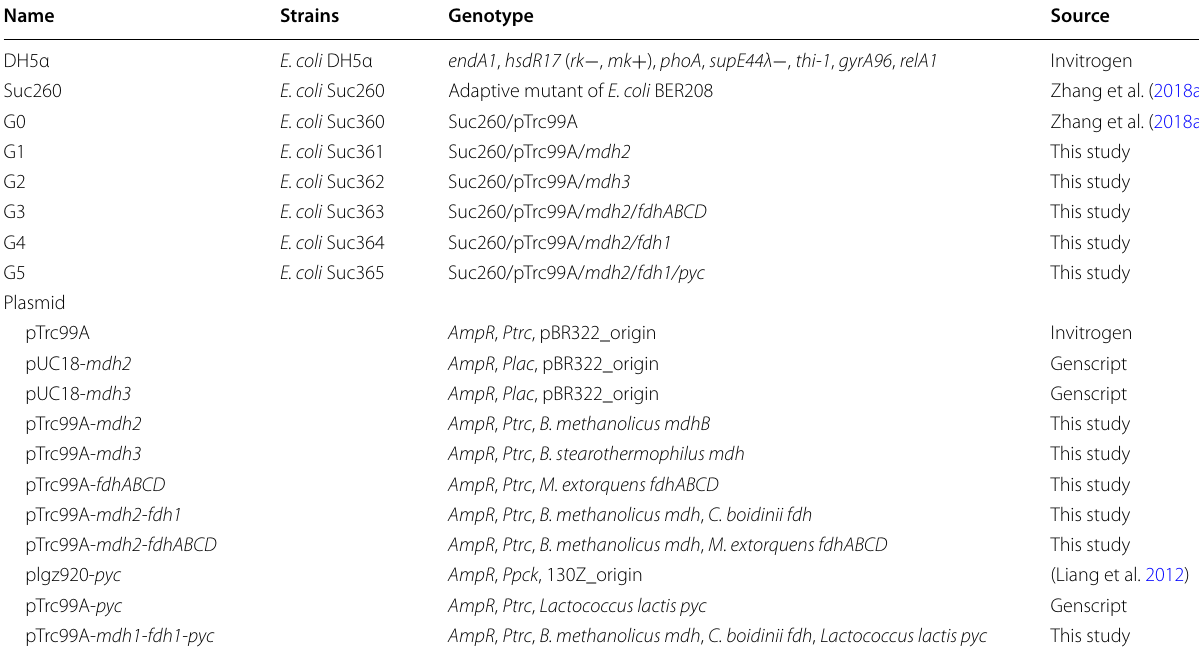
Table 1 Strains and plasmids used in this